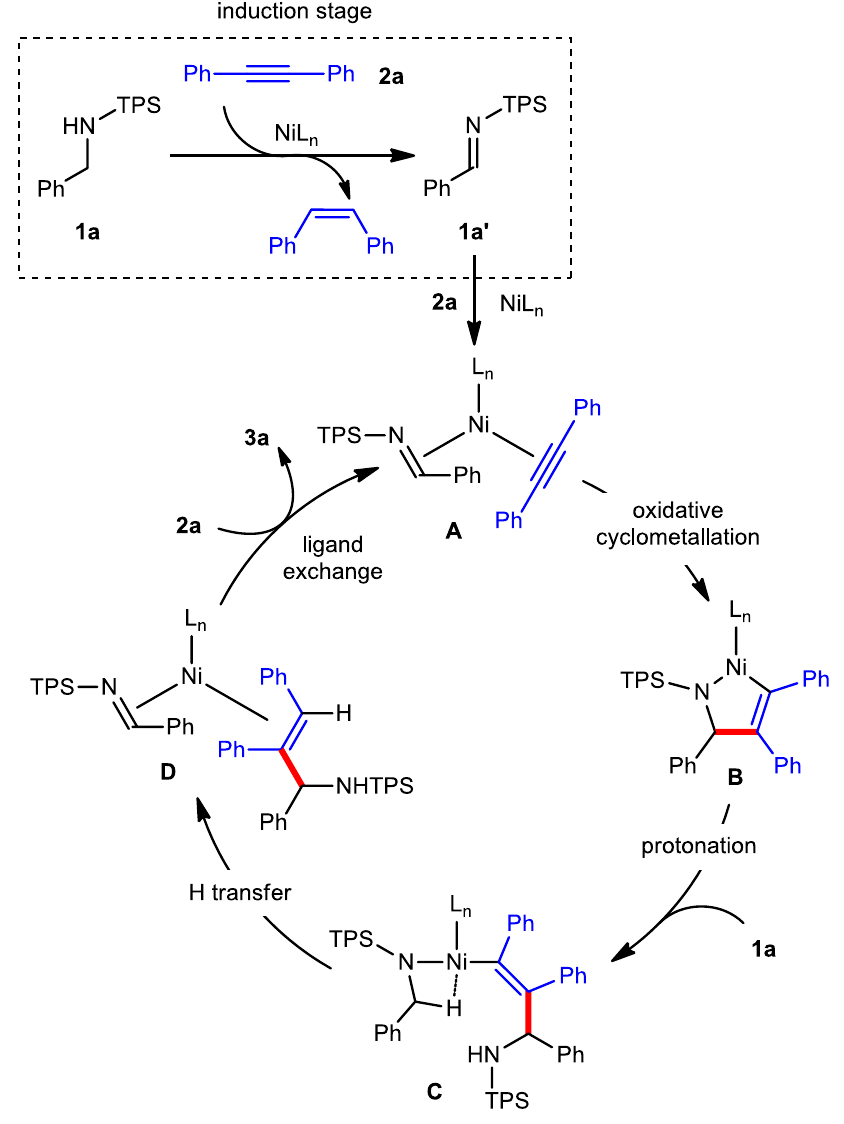
Fig. 6 Proposed mechanism. Induction stage and catalytic